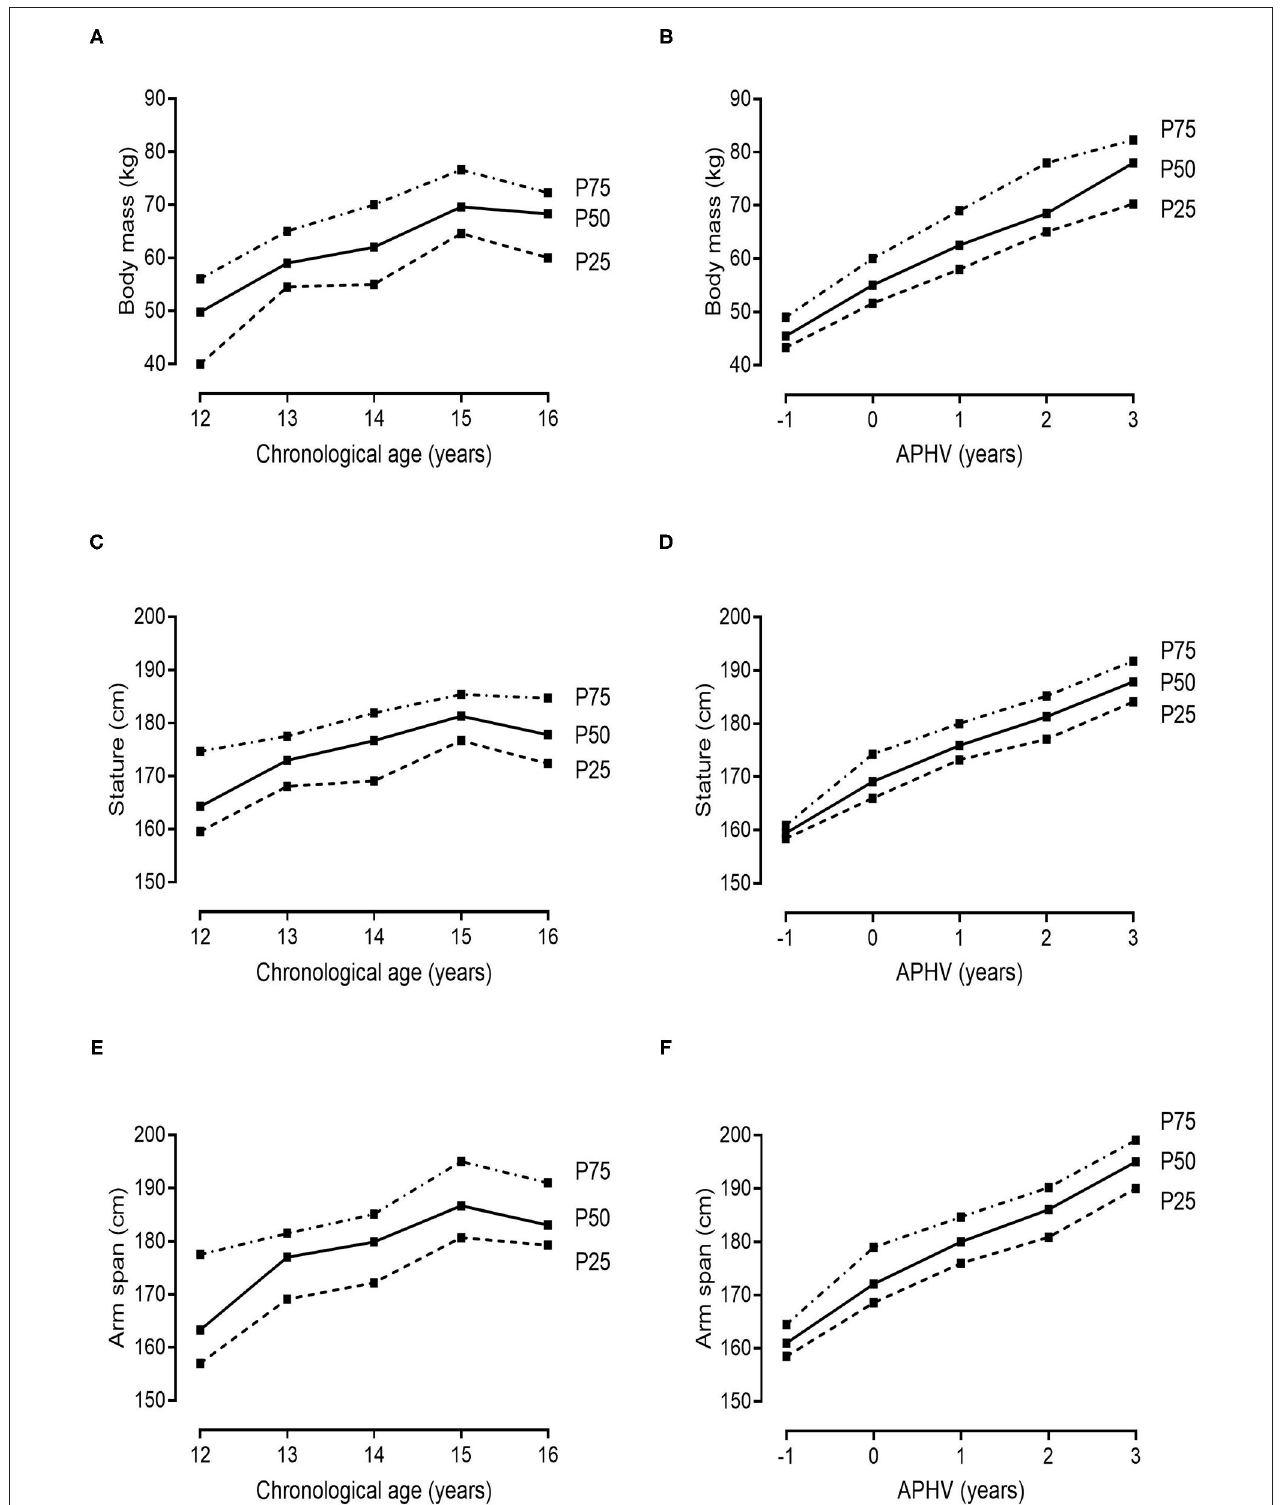
FIGURE 3 | References values (10th, 25th, 50th, 75th and 90th percentiles) for CMJ and CMJ-S height of young Portuguese male basketball players, according to their chronological age and maturity status.